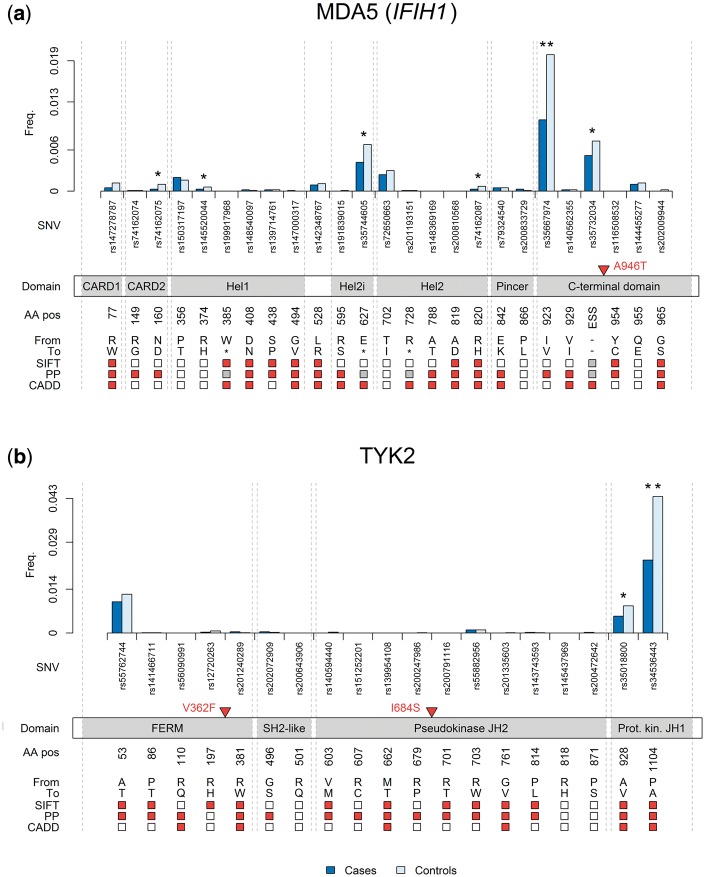
Rare and low-frequency protein-altering variants in IFIH1 and TYK2. Frequency of alternative allele in cases and controls across all four studies for rare and low-frequency variants, displayed by protein consequence. ** designates exome-wide significant association (P < 3.0 × 10−7); * designates nominally significant association (P < 0.05). Common protein-altering variants that we report to be associated are marked by red triangles. Variant effect predictions (by SIFT, PolyPhen-2 and CADD) are red where a substitution is predicted to be damaging, white where it is not, and grey where no prediction was possible. SNV = single nucleotide variant; ESS = essential splice site; AA pos = amino acid position; PP = PolyPhen-2. (A) IFIH1 variants (MDA5 protein): CARD = caspase activation recruitment domain; Hel = helicase domain. (B) TYK2 variants: FERM = 4.1/ezrin/radixin/moesin domain; SH2-like = Src homology 2-like domain; JH2 = JAK-homology 2; Prot. kin. JH1 = protein kinase JAK-homology 1.